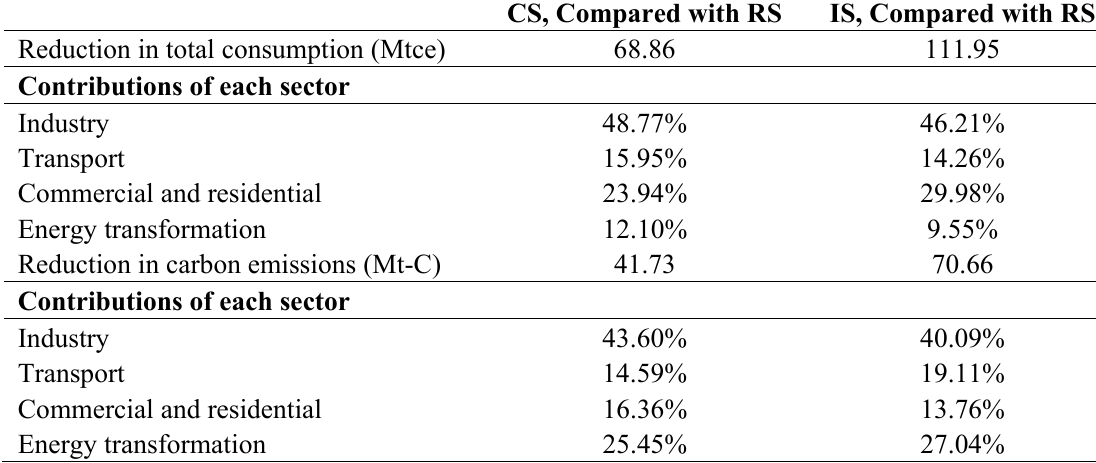
Table 8. Comparison of potential for energy savings and carbon emissions reductions during the period studied. CS, Compared with RS IS, Compared with RS